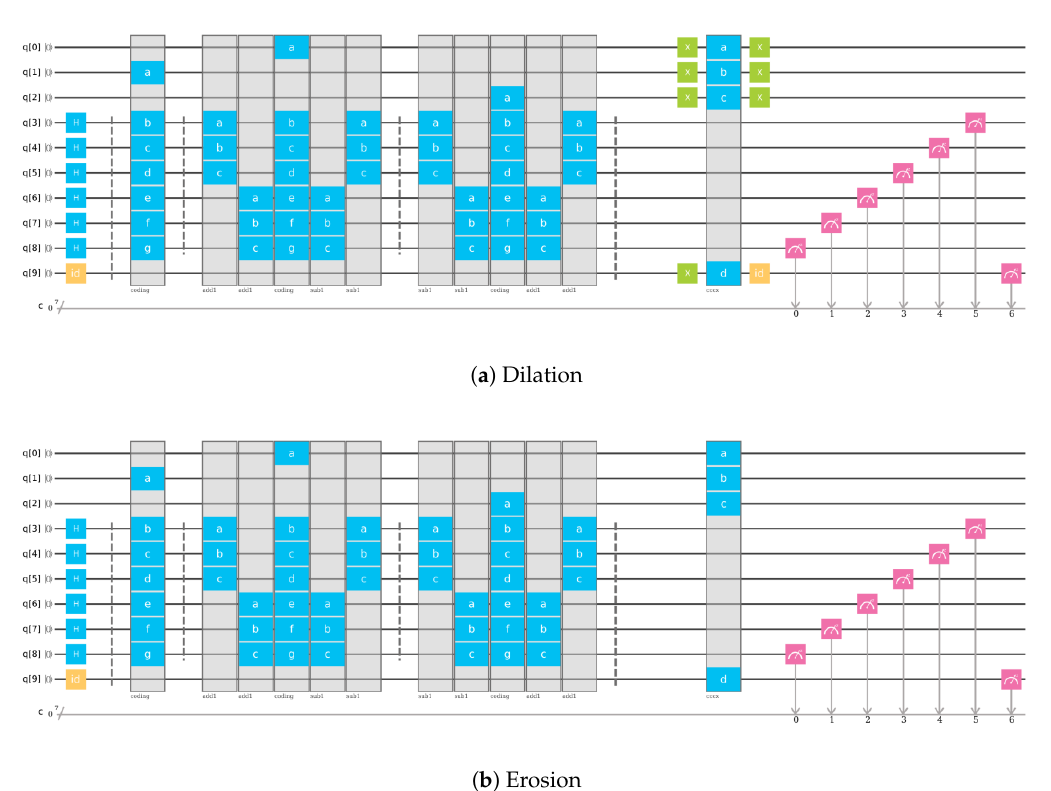
Figure 10. The circuits for dilation and erosion operation to the image (Equation (13)) by the structure element shown by Figure 7. The qubit q [ 1 ] is for | G Y , X (cid:105) , q [ 0 ] for | G Y − 1, X − 1 (cid:105) , q [ 2 ] for | G Y , X (cid:105) , q [ 3 ] q [ 4 ] q [ 5 ] for | Y (cid:105) , q [ 6 ] q [ 7 ] q [ 8 ] for | X (cid:105) and q [ 9 ] for the result | O (cid:105) . To the very left side the Hadamard gates for ∑ 2 n − 1 | Y (cid:105) ⊗ ∑ 2 n − 1 | X (cid:105) . The “coding” subroutine can | Y (cid:105) and | X (cid:105) convert the all | 0 (cid:105) state to | I (cid:105) = 1 0 X = 0 2 n Y = 0 code the | G Y , X (cid:105) by the location states while retain the quantum states for position qubits after the operation. The blue blocks with “H” are the Hadamard gates, and the yellow blocks with “id” are identical operations that actually do nothing to the qubits. They are put there only for the symmetry of the circuit considering the possible errors from applying operations.The subroutines “coding”, “add1” and “sub1” are discussed above. (See Figures 6, 8, and 9). The “cccx” subroutine is simply a NOT gate with three control qubits, which is one more than a normal Toffoli gate, where a ∼ c are control qubits and d is the target. The pink blocks denote the measurements, where we can see the grey arrows showing that information is passed to classical bits. Then we can get the result | O (cid:105) in q [ 9 ] which is read out in the classical bit